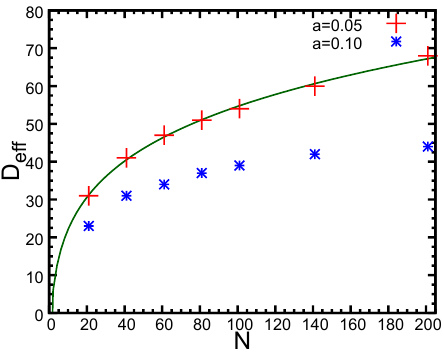
Figure 12 . The system size dependence of the effective bond dimension with a = 0 . 05 (red, + ) and a = 0 . 10 (blue, ∗ ) for the charge q = 3 case with m lat . = 1 . 00 , θ/ (2 π ) = 1 . 50 at the 10th sweep. The green solid line shows a fitting curve by the function c 1 N 1 / 6 + c 2 with some constants c 1 , 2